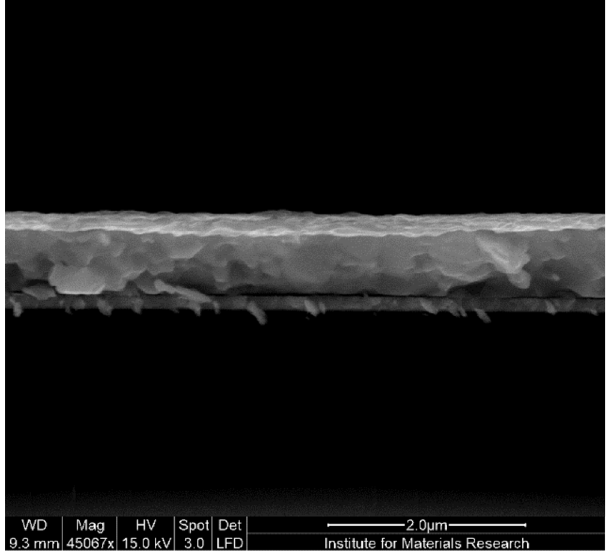
Fig. 14. Spherical defect on top of a perovskite layer deposited by USSC and gas quenching.